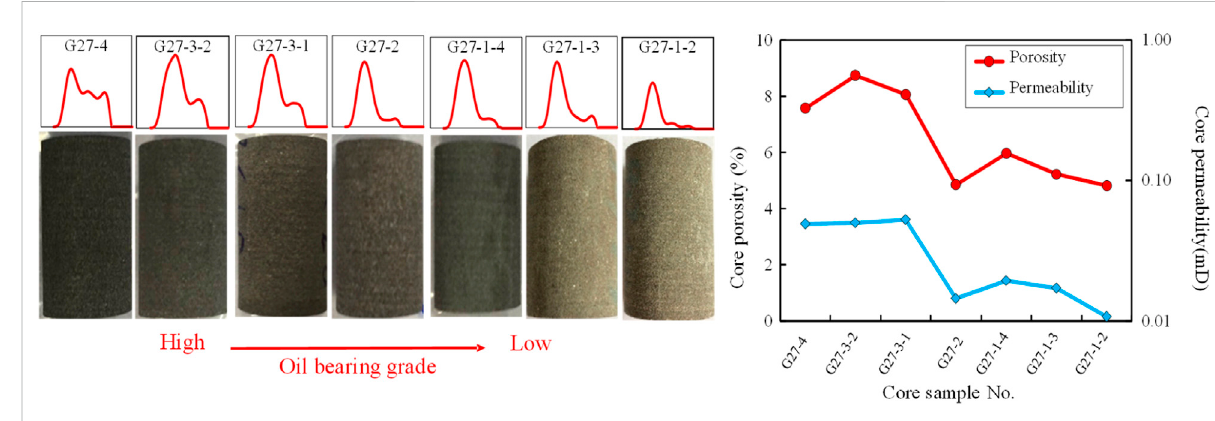
FIGURE 8 Variation of oil-bearing grade with physical properties and pore structure (Well G27)